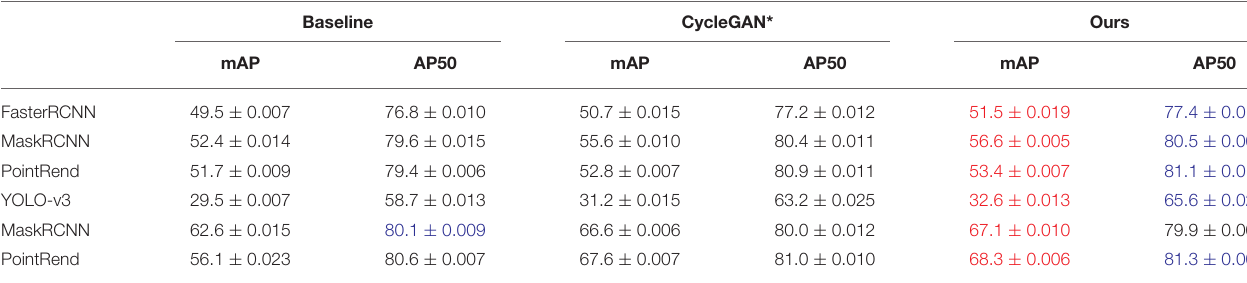
TABLE 7 | Performance of object detection and instance segmentation for tomato leaves in multiple deep learning-based models.